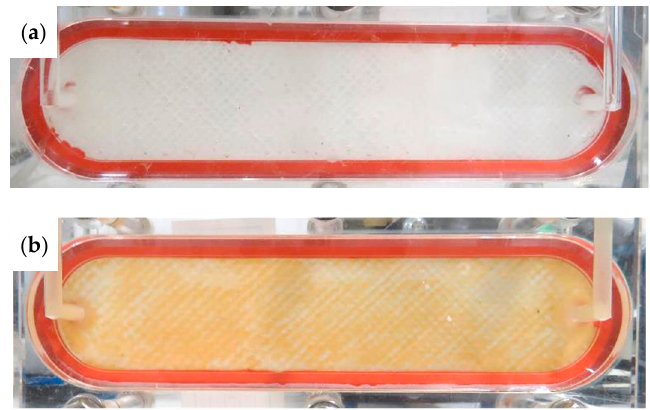
Figure 6. Reduction in normalised flux and conductivity difference between the FS and DS ( ∆ C ) during the (i) first and (ii) second pre-concentration tests using primary wastewater effluent: ( a ) chloraminated and ( b ) non-chloraminated FO systems.